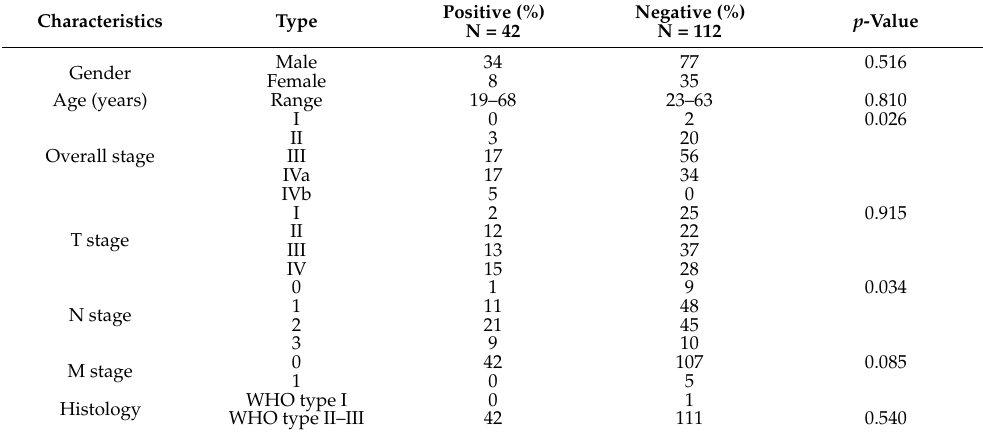
Table 1. Clinical characteristics of the patients with NPC in the relapsed or metastatic group and the non-relapsed or metastatic group.